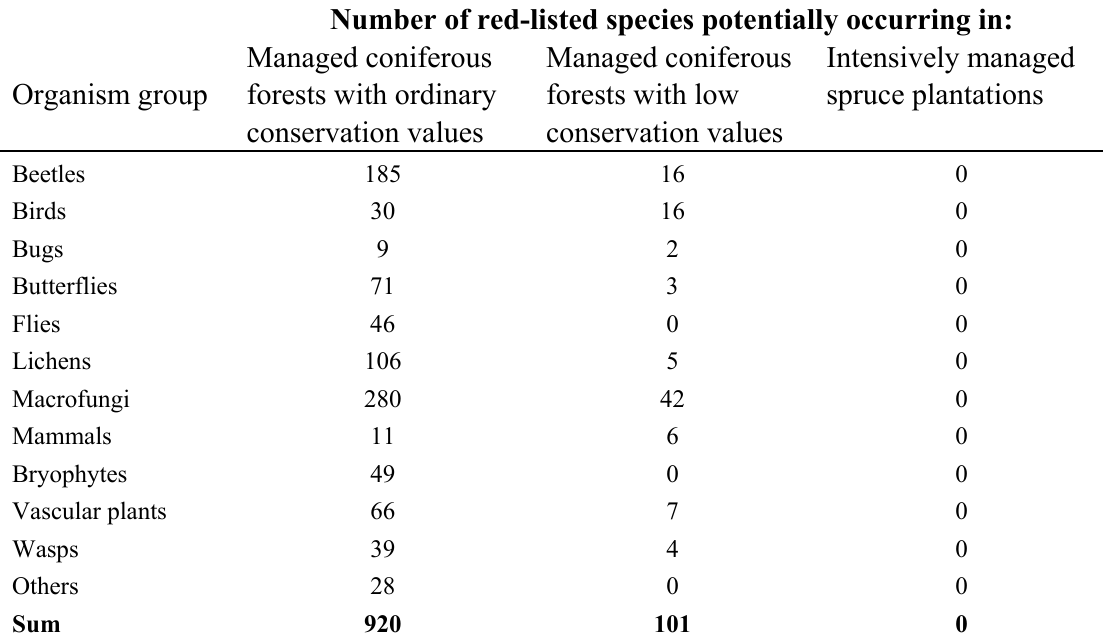
Table 1. Number of Swedish red-listed species potentially inhabiting three types of managed coniferous forests, assessed on the basis if habitat, substrate and abiotic conditions may be appropriate for their presence. The species are divided into organism groups. The total number of red-listed species occurring in Swedish forests is 1862